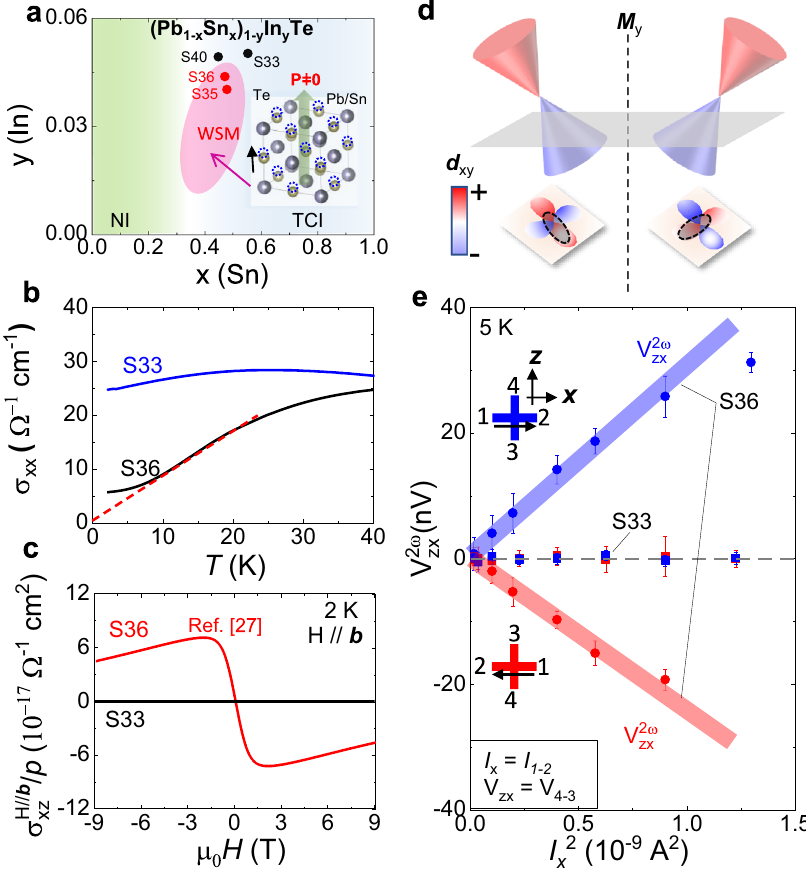
Fig. 1 Nonlinear Hall signals observed in a ferroelectric Weyl semimetal system of (Pb 1 − x Sn x ) 1 − y In y Te. a Schematic phase diagram of In- doped PbTe – SnTe; an intermediate Weyl seimimetal (WSM) phase appears between normal insulator (PbTe) and topological crystalline insulator (SnTe) with intrinsic ferroelectric order. Inset shows the distorted structure of WSM phase with polar axis along z axis. The fully mapped phase diagram with many data points can be found in ref. 26 b Temperature-dependent conductivity of the two prototypical samples, S33 and S36. Red linear, dashed line fi ts conductivity of S36 at temperature below 20 K. c In-plane Hall effects measured in S33 and S36 show vanishing and sizable signals, respectively. σ in - plane xz = p of S36 is adapted from ref. 27 d The Berry curvature dipole related by the mirror plane displays a certain structure of symmetry of sign, as indicated by the colors of d xy . e The nonlinear Hall effect (NLHE) measured for S33 and S36 shows vanishing and sizable signals, respectively. Inset shows the experimental con fi gurations of current and Hall contacts. The error bars represent the standard deviation of the measured